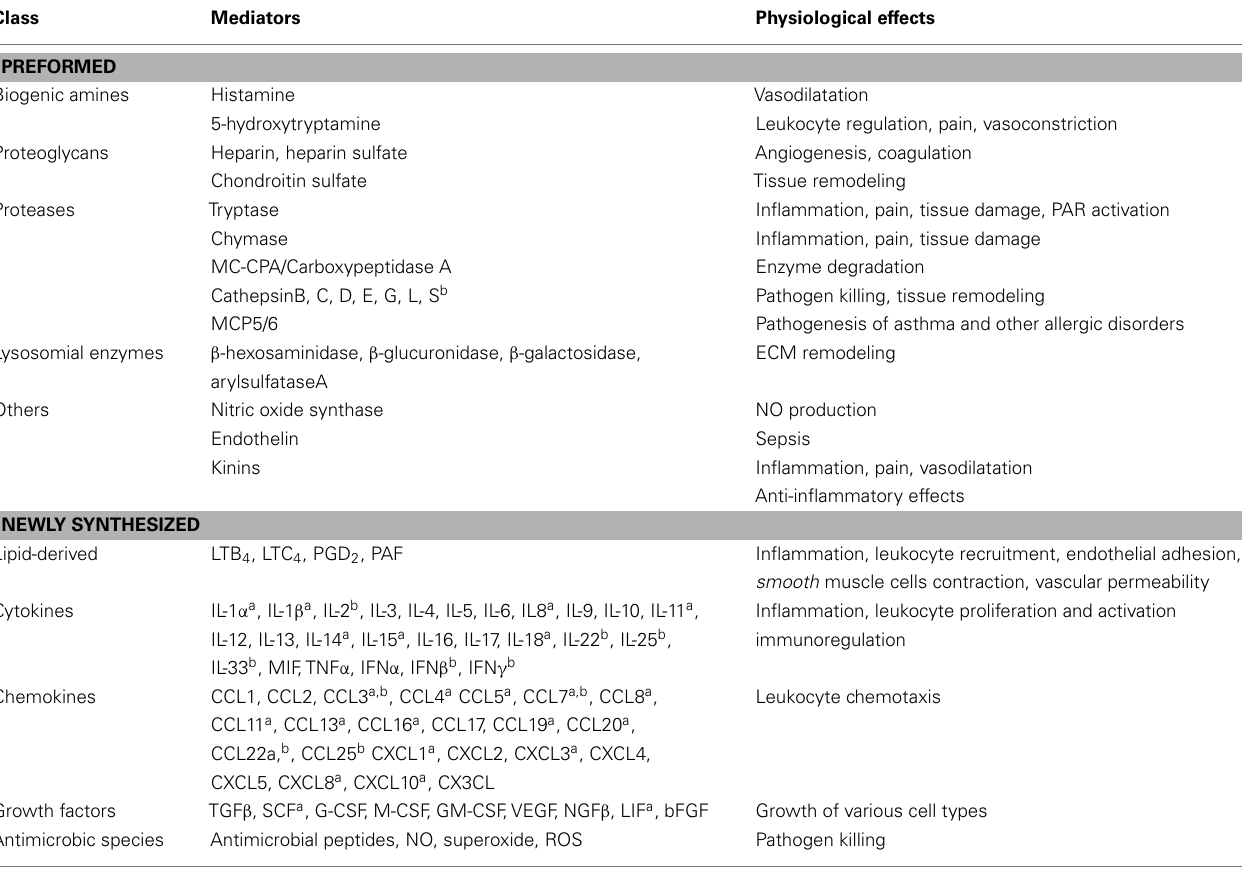
Table 2 | Major MC-derived